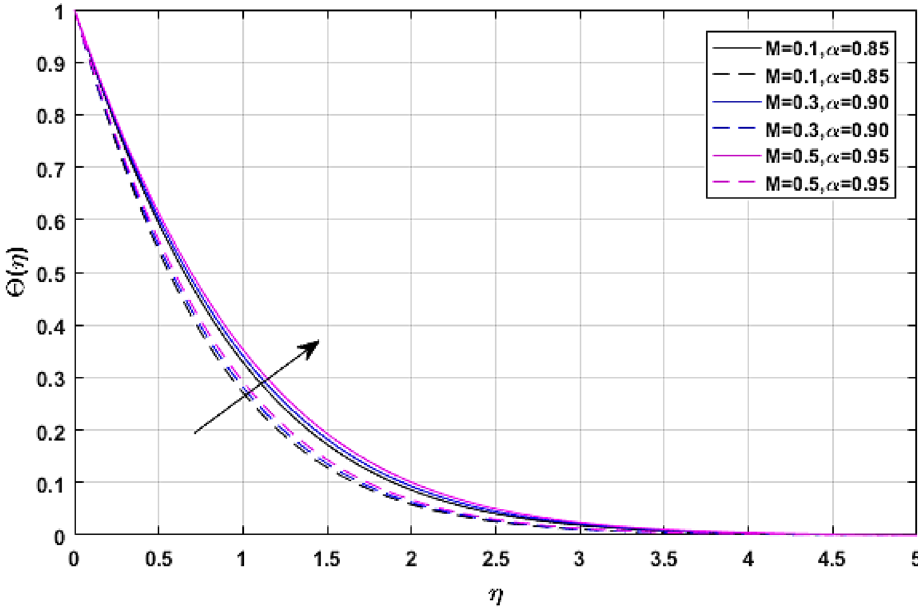
Figure 12. M versus temperature field when (cid:31) = E = Ec = 0.1, φ 1 = φ 2 = 0.02, Pr = 21.